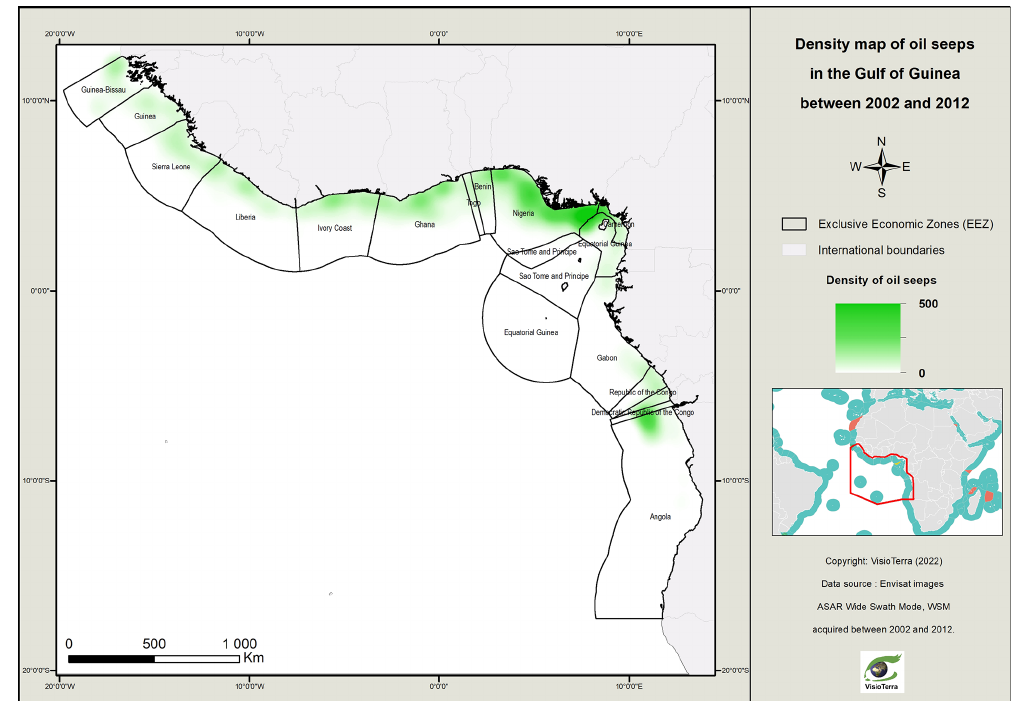
Figure 12. Density map of oil seeps in the Gulf of Guinea between 2002 and 2012.